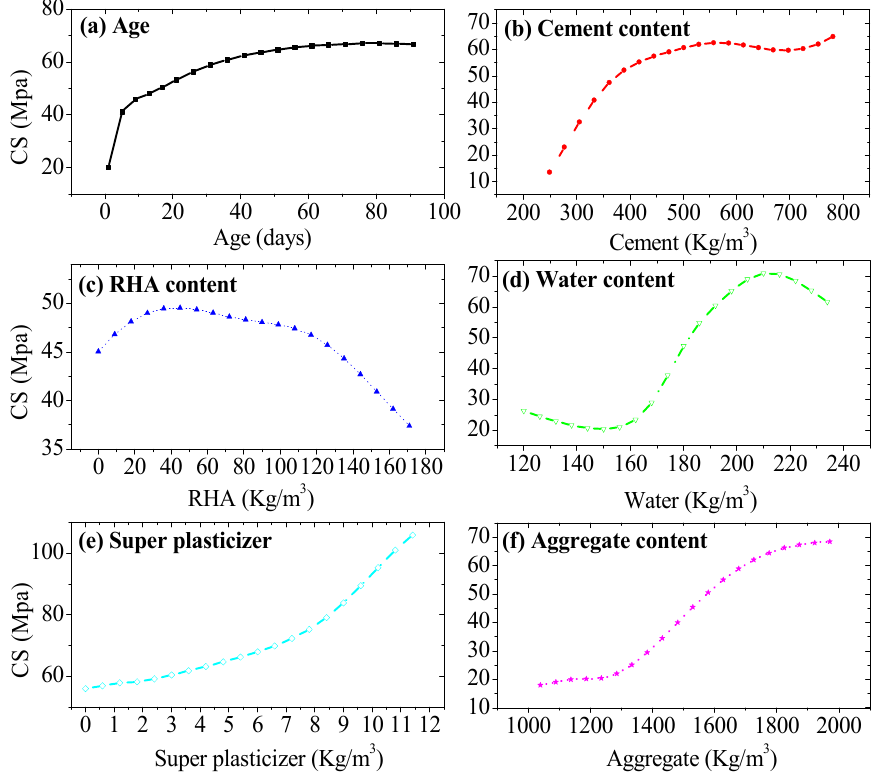
Figure 9. Parametric analysis of inputs: ( a ) age, ( b ) cement content, ( c ) RHA content, ( d ) water content, ( e ) superplasticizer, and ( f ) aggregate content.